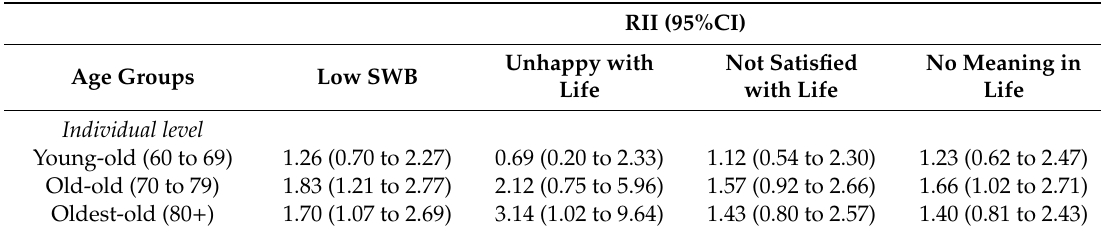
Table A1. Multilevel associations of education and components of and overall subjective well-being, stratified by age